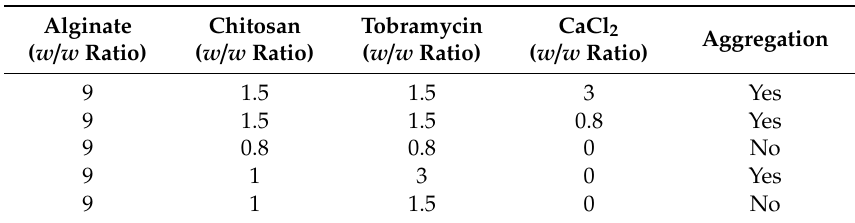
Table 1. Optimisation of formulation parameters in the design of alginate / chitosan particles. Results presented as mean ± standard deviation (S.D.), N =